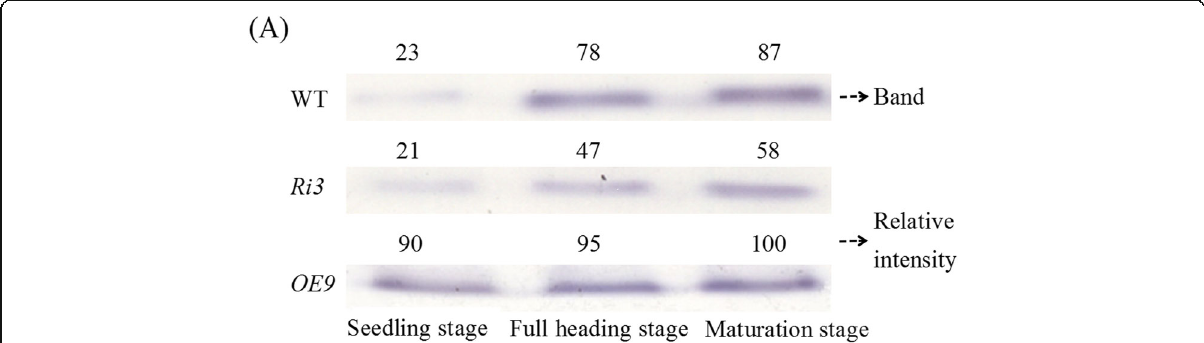
Fig. 5 XDH enzyme activity in wild-type and transgenic lines at different growth stages. The seedling, full heading and maturation stages of rice were grown to 14d, 60d, and 90d after sowing, respectively. The penultimate leaves were selected at seedling stage and sword leaves of transgenic plants were selected for extraction soluble protein at full heading and maturation stages. Each lane in the gel was loaded with equal content soluble protein. XDH activity was detected in gel with hypoxanthine as substrate. Numbers above the lanes indicate relative intensity obtained by scanning the formazan bands with a computing laser densitometer using Image J 2x